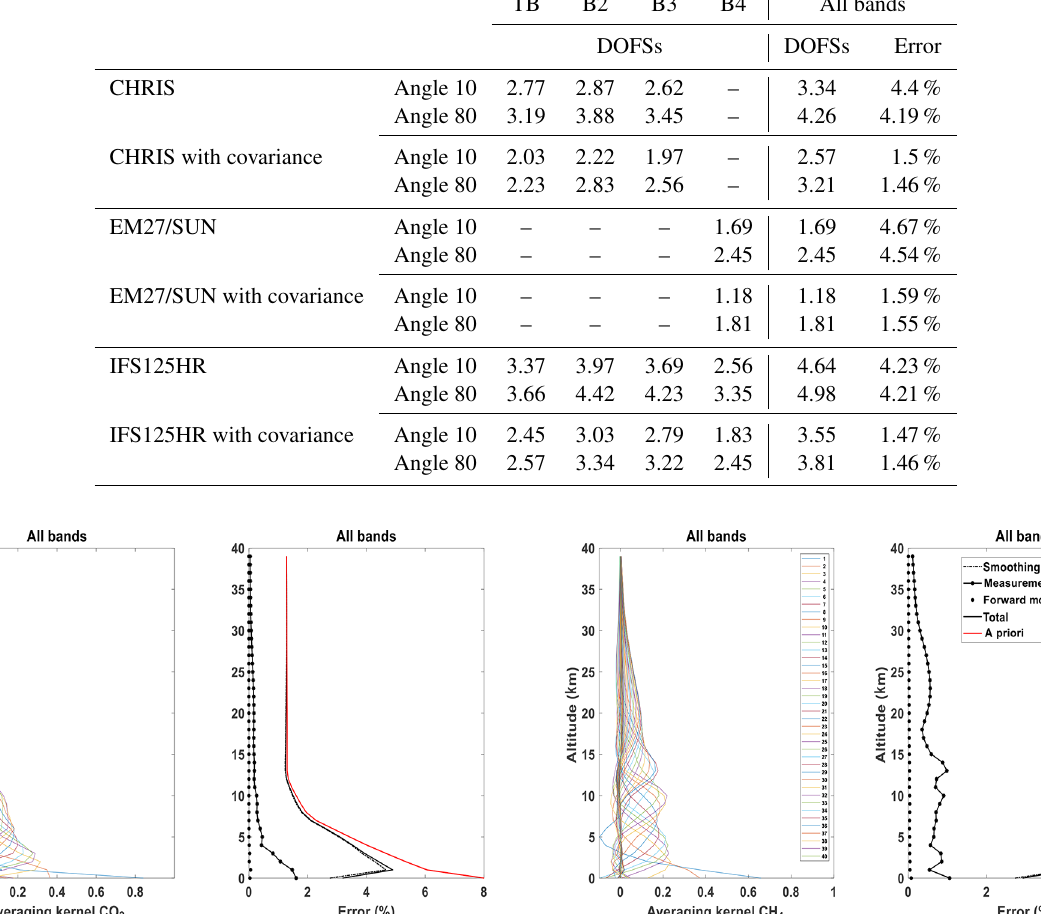
Figure 11. Averaging kernels and error budgets of CO 2 and CH 4 and vertical profiles for all the bands together for an angle of 10 ◦ for the IFS125HR. The red and black lines stand for the prior ( S a ) and posterior ( S x ) errors, respectively; the smoothing ( S smoothing ), measurement ( S meas. ) and forward model parameter ( S fwd.mod. ) errors are dash-dotted, dash-starred and dotted, respectively.